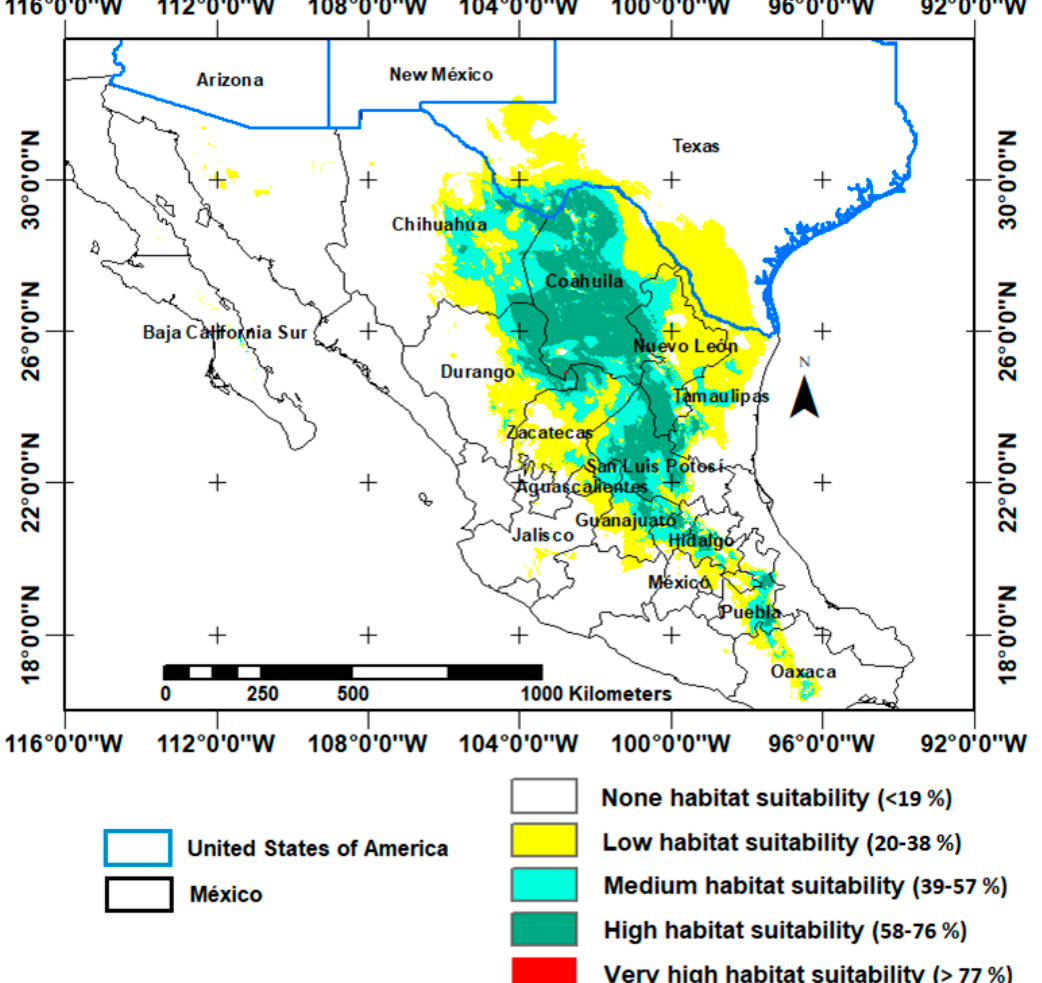
Figure 4. Current habitat suitability of candelilla in Mexico and The USA.